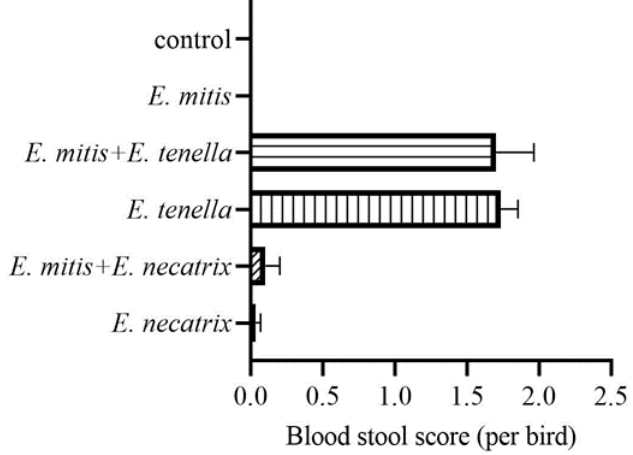
Figure 2. The blood stool score of chickens with single and mixed infections of Eimeria species.